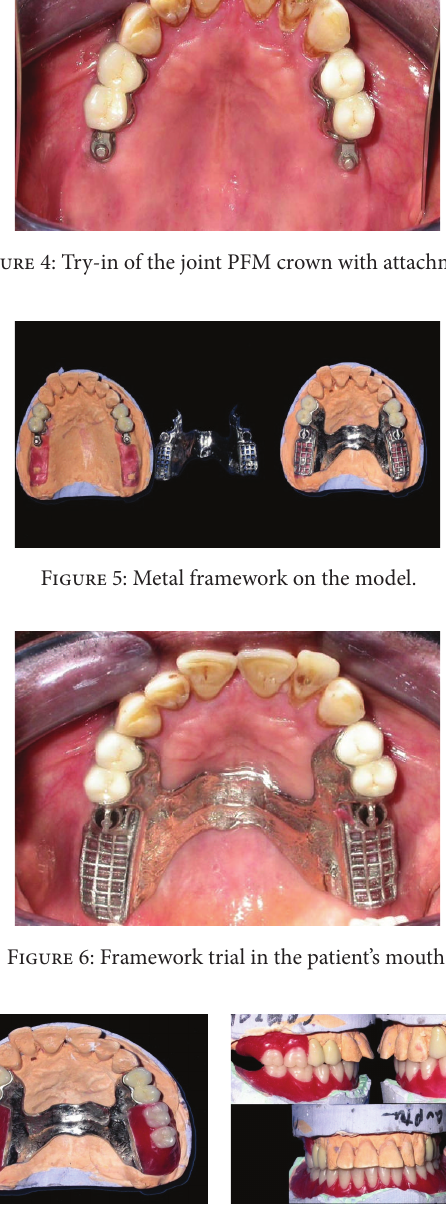
Figure 7: Waxed-up denture on